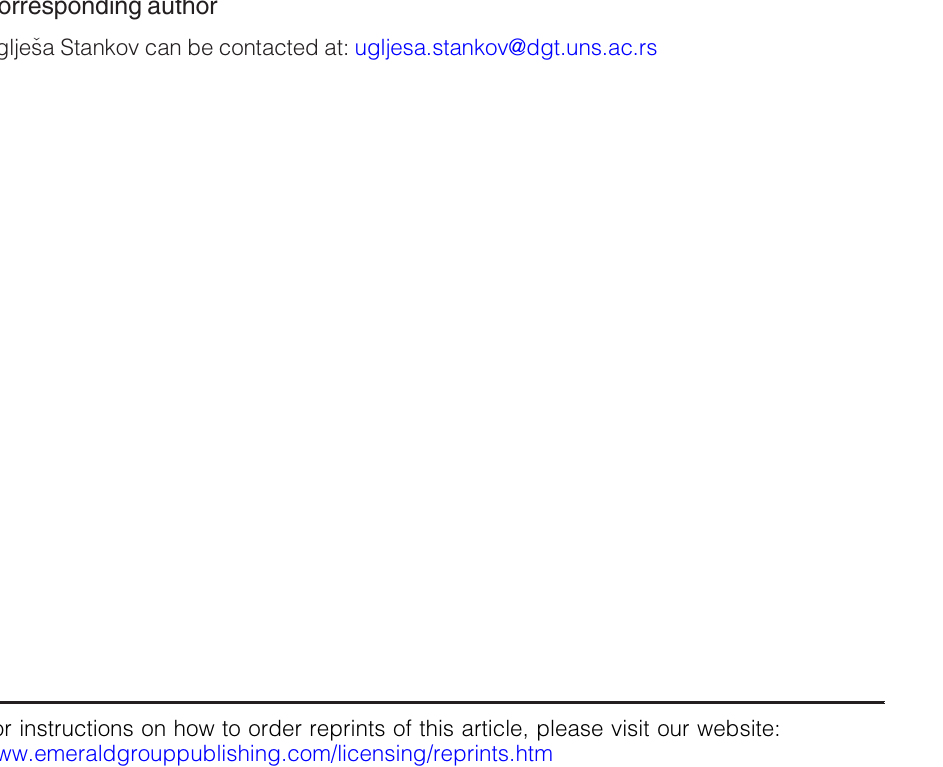
For instructions on how to order reprints of this article, please visit our website: www.emeraldgrouppublishing.com/licensing/reprints.htm Or contact us for further details: